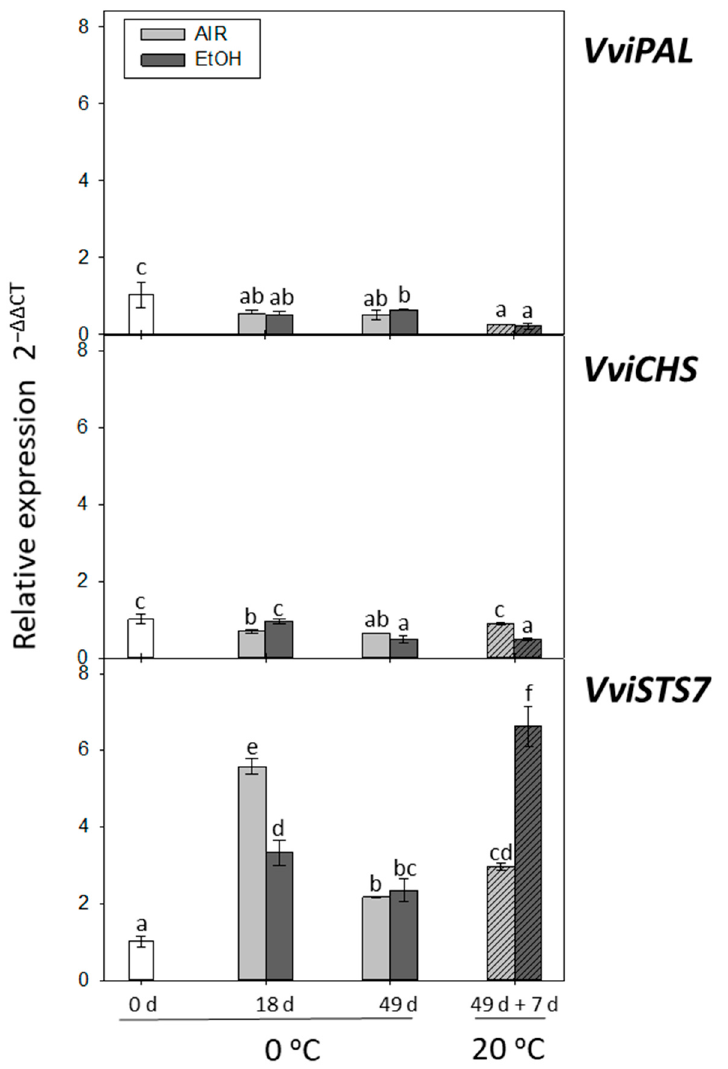
Figure 2. Effect of low temperature and ethanol treatment on VviPAL, VviCHS , and VviSTS7 gene expression in the skin of It 681–30 table grapes stored for 49 days at 0 °C and after the shelf-life period (49 d + 7 d at 20 °C). The transcript levels of each gene were assessed by RT-qPCR and normalized using Actin1 as a reference gene. The results were calculated relative to a calibrator sample (time 0) using the formula 2 −ΔΔ Ct . Values are the mean ± SD, n = 6. Different letters on bars indicate that the means are statistically different using the Tukey-b test ( p < 0.05).